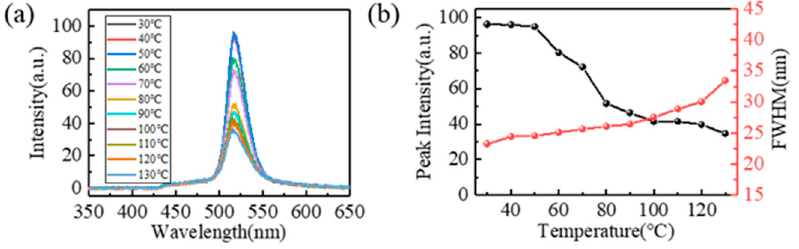
Figure 7. Luminescence performance test of FQCL at different temperatures. ( a ) Spectral curves of FQCL, ( b ) peak intensity, and FWHM of FQCL.